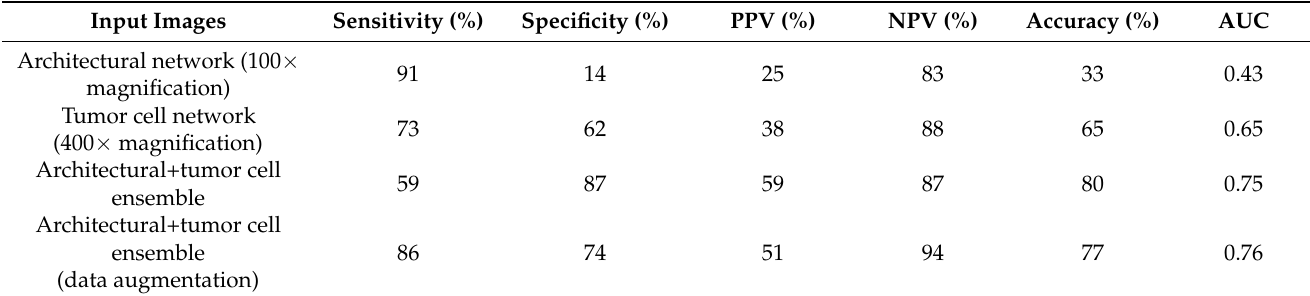
Table 2. Performance evaluation of cohort II (external validation set) ( n = 91).